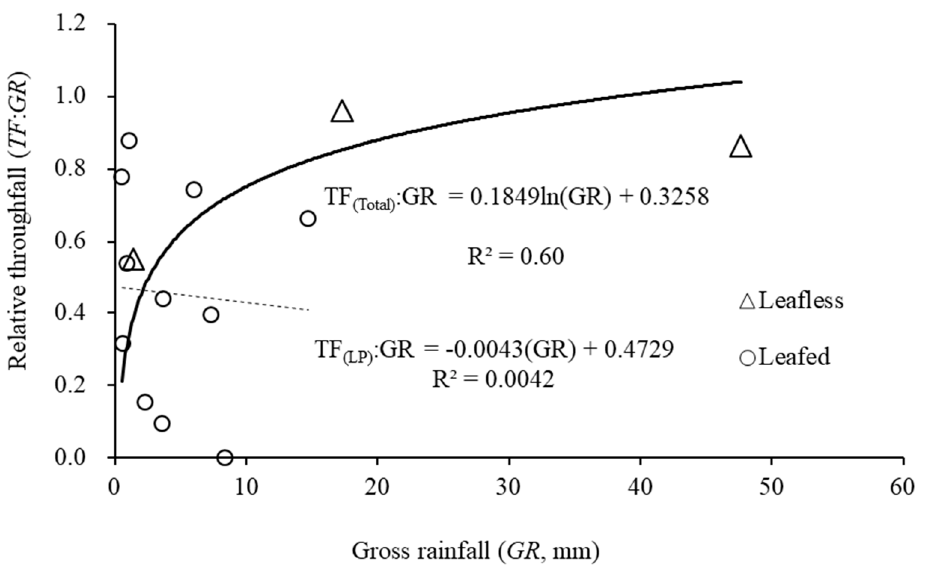
Figure 2. Regression analysis between relative throughfall ( TF : GR ) and gross rainfall ( GR ) during leafless (triangles) and leafed (circles) phenoseasons. LP = Regression line plotted for the leafed period, Total = Regression line plotted for all leafed and leafless data.